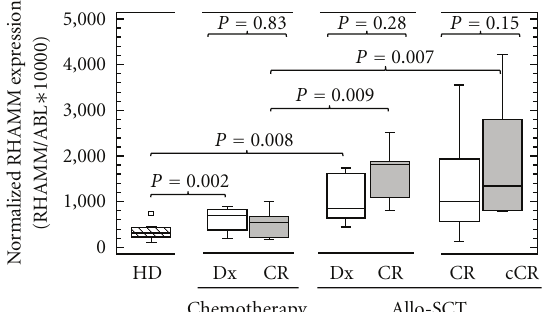
Figure 1: RHAMM expression before and after chemotherapy alone or allo-SCT. Patients at diagnosis had higher copy numbers when compared to healthy donors (chemotherapy group, P = 0 . 002; allo-SCT group, P = 0 . 008). There was no significant di ff er- ence in expression of RHAMM before (white boxes) and after (grey boxes) treatment, neither for chemotherapy alone ( P = 0 . 83) nor for allo-SCT ( P = 0 . 28), in patients at diagnosis that reached a CR after treatment. Also patients in CR that received allo-SCT showed no di ff erence in RHAMM transcripts before (white boxes) and after (grey boxes) transplant ( P = 0 . 15). However, patients that received allo-SCT had higher copy numbers when compared to those who received chemotherapy during the CR ( P = 0 . 009) or continuous CR (cCR, P = 0 . 007). Medians are shown in the box